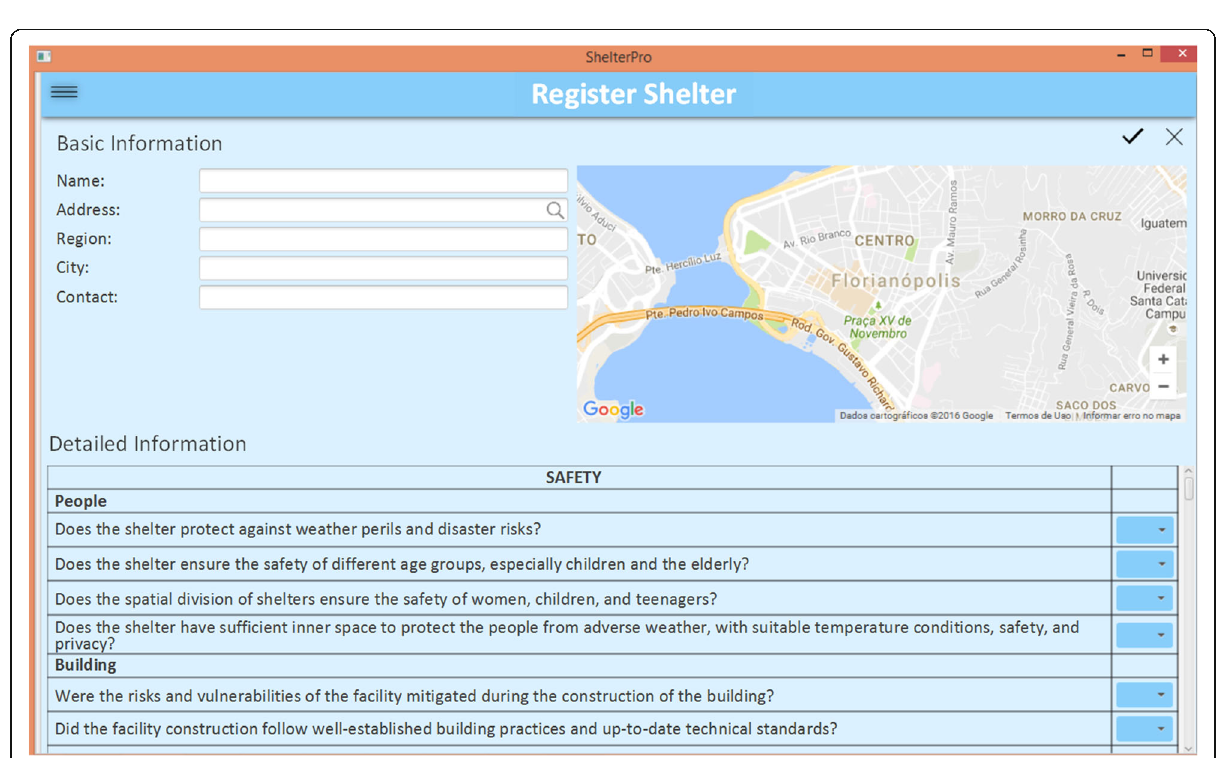
Fig. 7. ShelterPro registration of a temporary